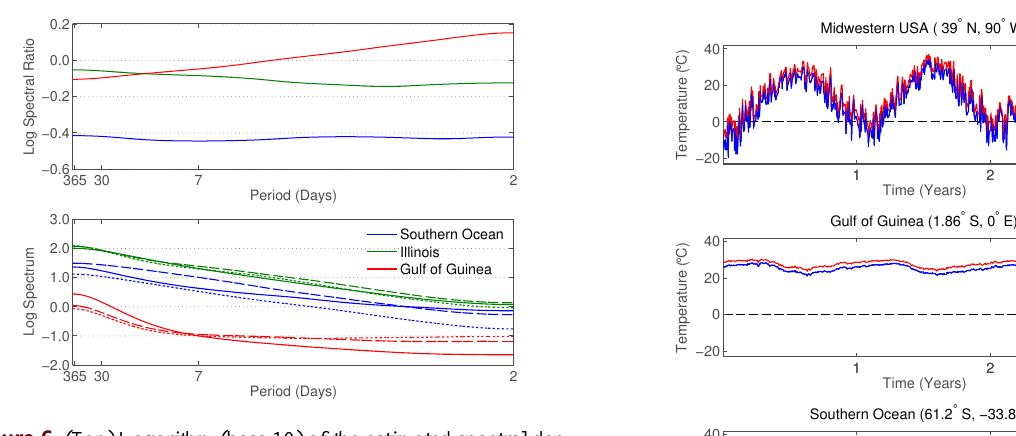
Figure 6. (Top) Logarithm (base 10) of the estimated spectral den- sity ratios in the Southern Ocean (blue), Illinois (green), and Gulf of Guinea (red). (Bottom) Logarithm of the estimated spectral den- sities of the reanalysis data (solid line), base period (dashed line), and scenario period (dashed and dotted line). The spectral density estimation was performed on the deseasonalized and demodulated time series.